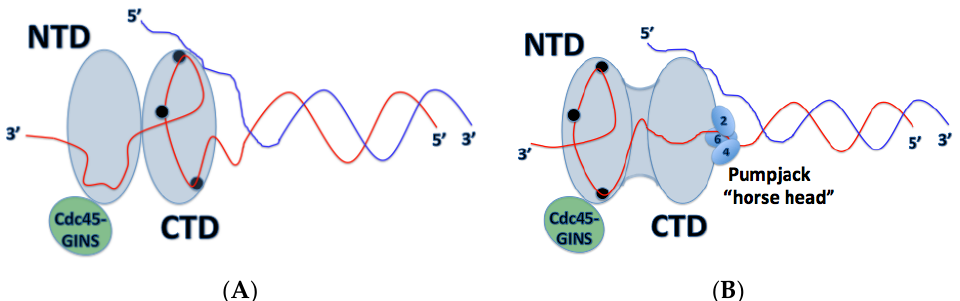
Figure 4. A view of the CMG helicase from a cut-away side view in its proposed pumpjack mechanism of Mcm2-7 translocation along ssDNA. The red strand indicates the leading strand DNA. ( A ) the Mcm2-7 hexamer in its compact state, where the CTD is bound to ssDNA. ssDNA passes through each domain 5′ → 3′ in a clockwise fashion. The black circles in the CTD represent the h2i/ps1β motifs, bound to ssDNA; ( B ) the Mcm2- 7 helicase is in its relaxed configuration with the “horse head” (consisting of subunits 2, 4 and 6) of the pumpjack up. DNA is not entirely bound to the CTD; however, it remains bound to the OB-folds (black circles) of the NTD.